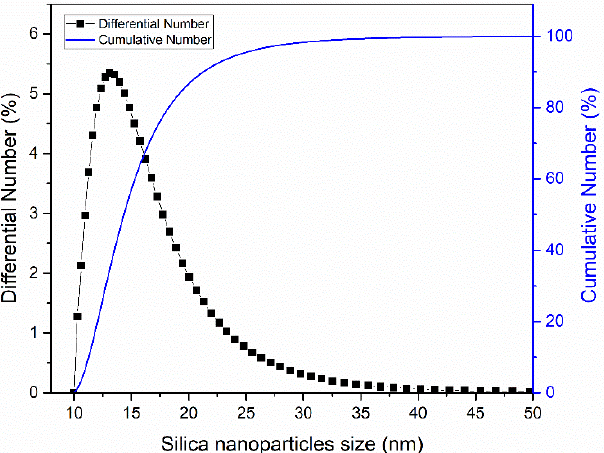
Figure 2. Distribution of silica nanoparticle size. This result was obtained using dynamic light scattering (DLS; Delsa™Nano, Beckman Coulter, Inc, Brea, CA, USA).